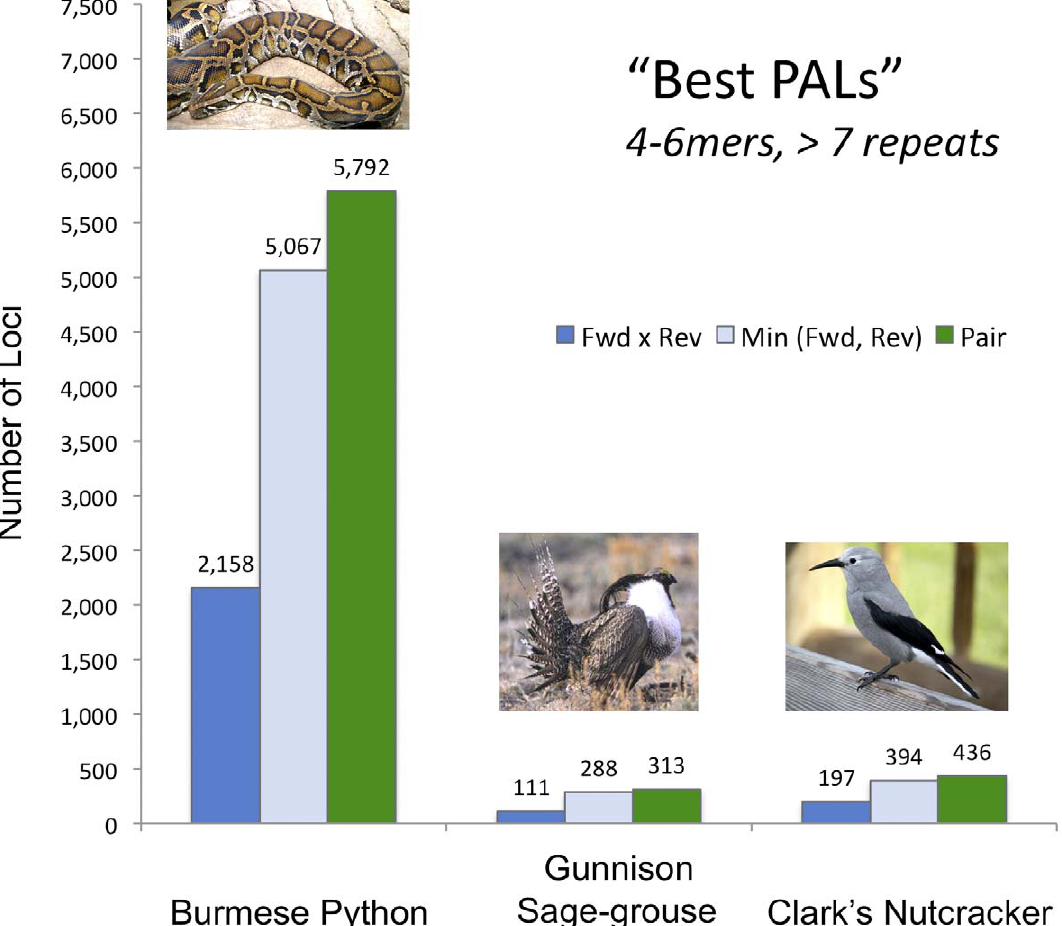
Figure 5. Highly stringent selection of choice microsatellite targets. Microsatellite loci were selected from the 5 million read datasets for each species that fit specific criteria for repeat monomer length (4–6), number of repeats observed ( . 7), and primer copy number in the observed data (variations shown above).